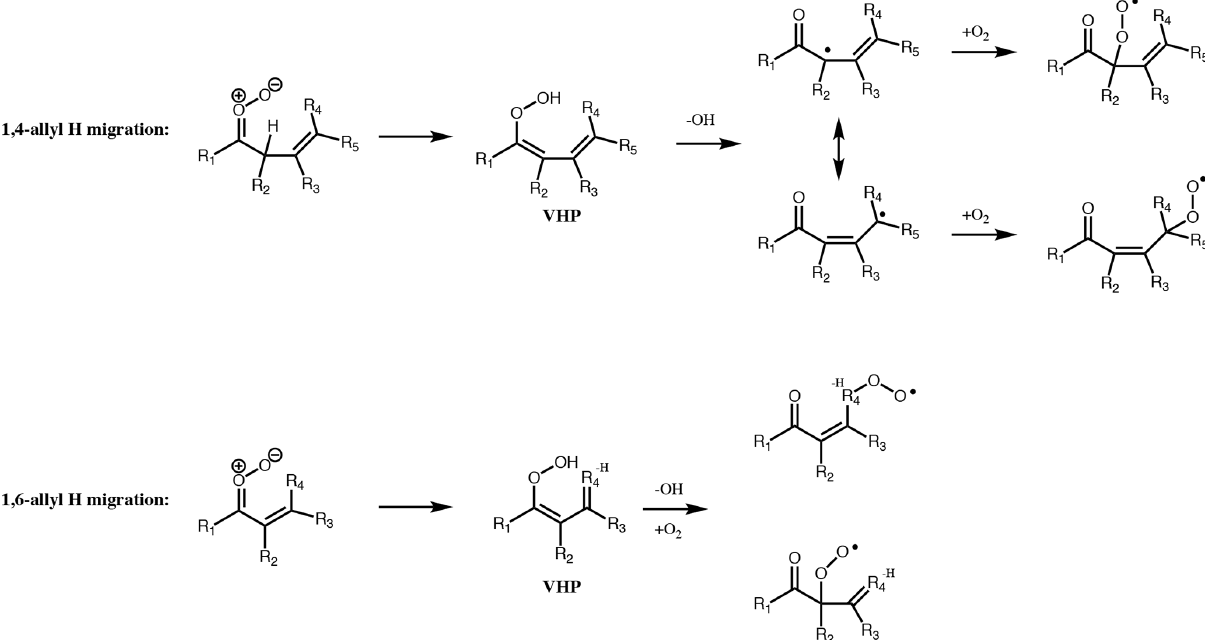
Figure 7. Dominant unimolecular decomposition routes available to unsaturated CI with the terminal oxygen syn to an α or β vinyl group. Pathways available if terminal oxygen anti to a vinyl group is the same as for saturated CI. For 1,5 ring closure, see Fig. 8.